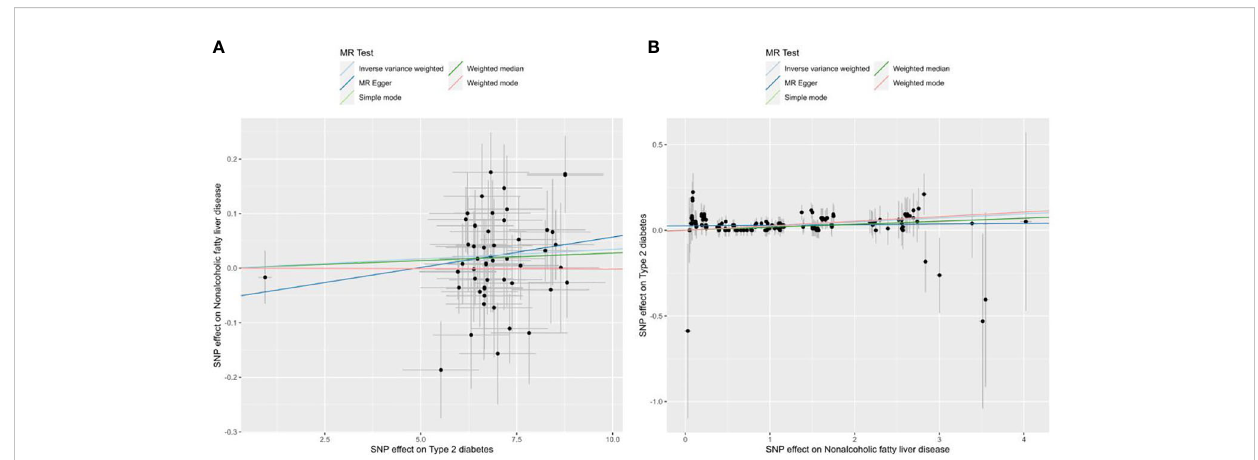
FIGURE 3 Scatter plots of the MR analysis. The light blue line shows the result of the IVW method, which has the most signi fi cant impact. The dark blue line shows the result of the MR Egger method; the light green is the result of the simple model method; the dark green is the result of the weighted median mode; and the red line represents the result of the weighted mode method. (A) Scatter plot of T2D as exposure and NAFLD as outcome. (B) Scatter plot of NAFLD as exposure and T2D as outcome.